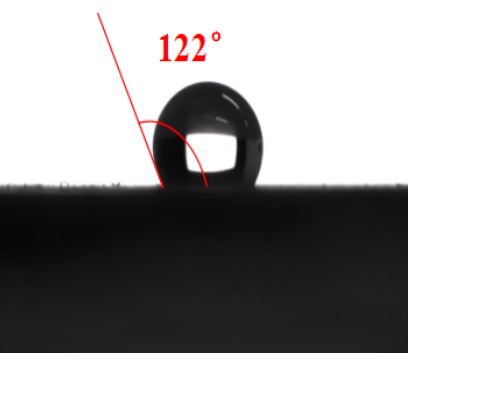
Figure 7. Contact angle of oil droplets on ( a ) water-wet core slice and ( b ) oil-wet core slice.